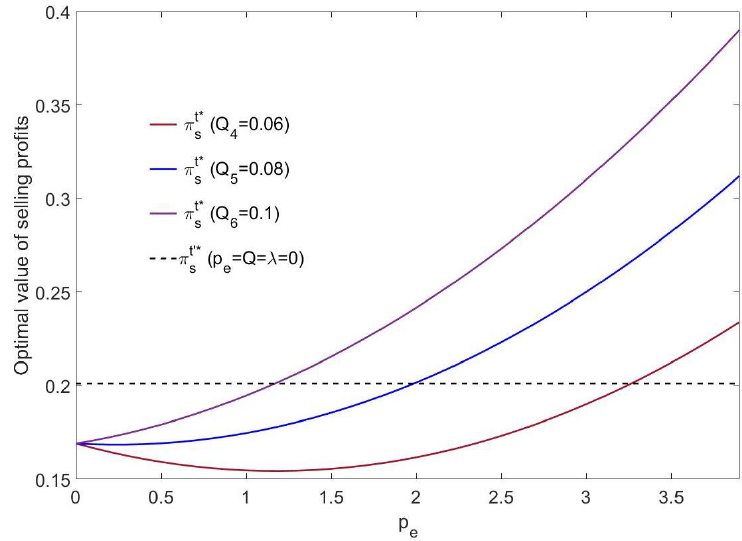
Figure 6. The effect of p e on the optimal selling profit ( λ 2 = 0.2).